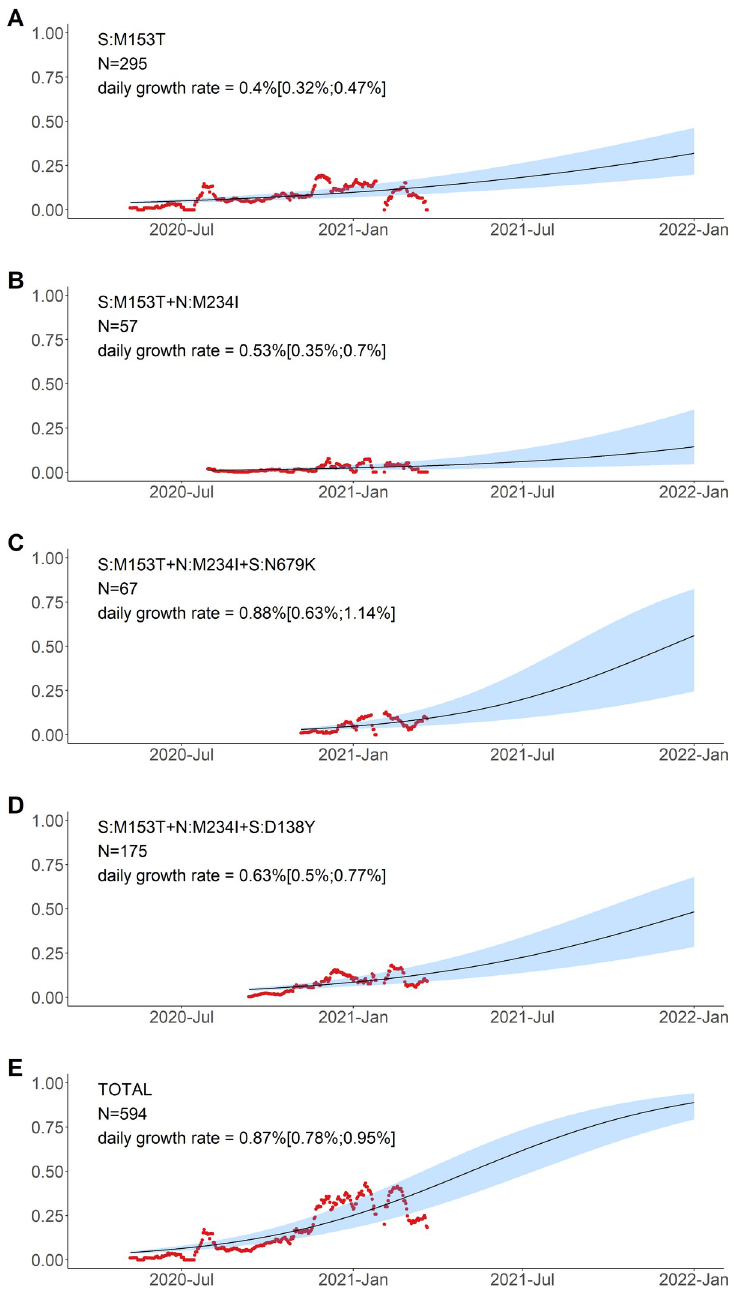
Fig 7. Logistic growth model for variants defined by amino acid changes in the S:M153T context. Notations are the same as in Fig 6.